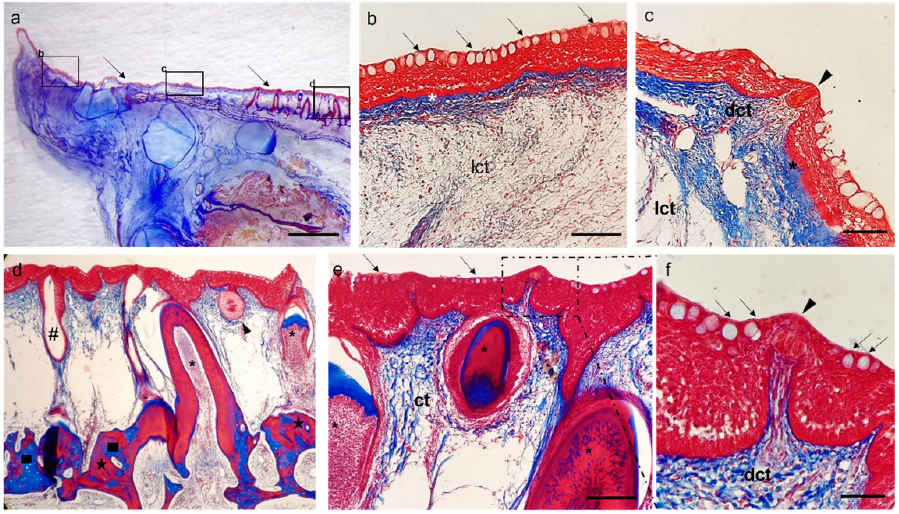
7 of 19 Figure 4. Gross anatomy. ( a ) Photograph of the right side of the gastrointestinal tract: esophagus (E), proventriculus (pv), gizzard (G), cranioventral blind sac (bs), spleen (s), accessory or supernu- merary spleen (arrowhead), pyloric appendages (pc), intestine (i). ( b ) Photographs of the right side of gizzard: pyloric ostium (arrow) visible after intestine and pyloric appendages removal. ( c ) Iso- lated intestine (i) and pyloric appendages (pc), anatomical relationships of the intestine and the py- loric appendages with the gizzard (insert). Scale bar: 1 cm. Histological Features The free apex of the tongue is covered by stratified epithelium with abundant calici- form cells inserted between the lining cells (Figure 5b). At the lingual dorsal surface, the mucosa is raised in folds and shows taste buds at both body (Figure 5c) and root levels (Figure 5d). In addition, villiform teeth in various eruption stages, glandular extraepithe- lial and intramural bodies as well as related excretory ducts and scattered taste buds, were